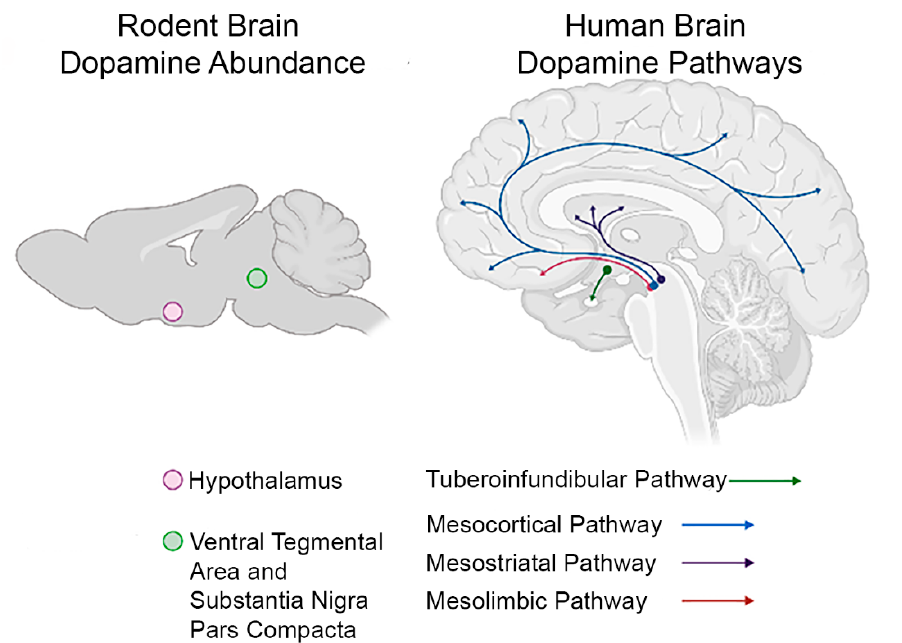
Figure 2. Dopamine distribution and pathways in the rodent and human brain. Dopamine neurons are located within the hypothalamus and the ventral tegmental area (purple circle) and substantia nigra pars compacta (green circle) in the rodent brain. In the human brain, dopaminergic neurons are located within the tuberoinfundibular (green), mesocortical (blue), mesostriatal (purple), and mesolimbic (red) pathways. Location of dopaminergic neurons within these multiple brain regions provides support that an environmental chemical contaminant (e.g., atrazine) targeting the dopaminergic system may impact multiple brain regions and thus multiple functions. Image created in BioRender.